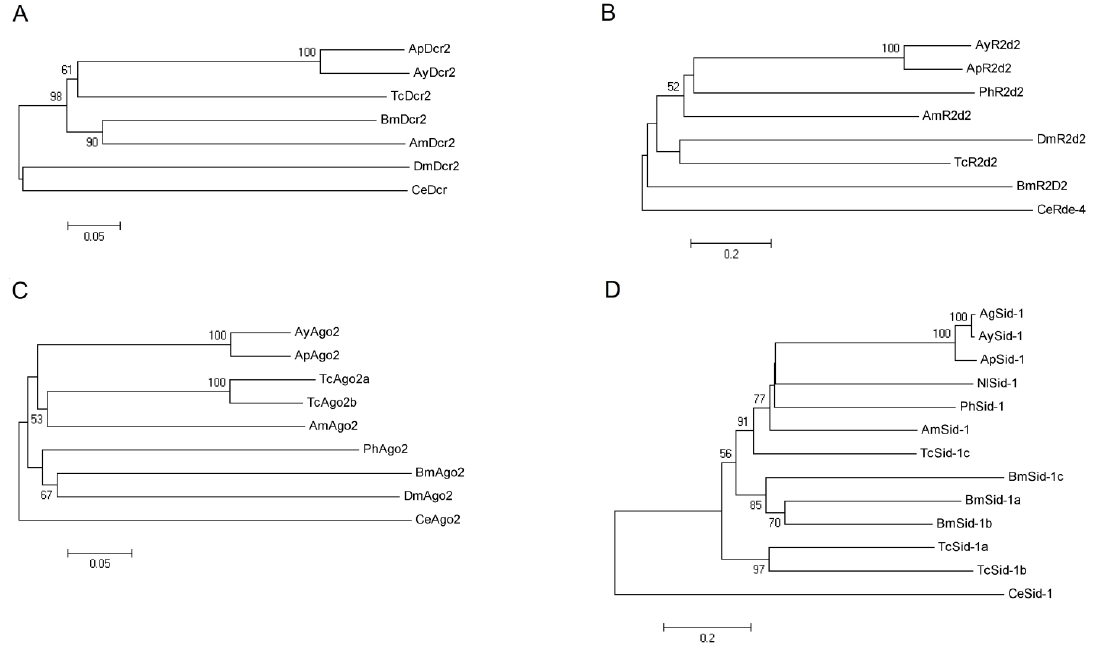
Figure 5. Phylogeny of insect Dcr2, R2d2, Ago2 and Sid1 proteins. The phylogenetic trees were constructed from amino acid sequences corresponding to RNAse IIIa, DS_RBD1, and PIWI domains of insect Dcr2 ( A ), R2d2 ( B ), and Ago2 ( C ) respectively. Full length protein sequences were used to construct the phylogenetic tree for Sid1 ( D ). The percentages of replicate trees in which the sequences clustered together in the bootstrap test (10000 replicates) are shown (only above 50%) next to the branches. The tree is drawn to scale, with branch lengths in the same units as those of the evolutionary distances used to infer the phylogenetic tree. The scale bar represents 0.2 ( B and D ) or 0.05 ( A and C ) expected substitutions per amino acid position. Various proteins for phylogenetic analysis were from Acyrthosiphon pisum (Ap), Aphis glycines (Ay), Aphis gossypii (Ag), Drosophila melanogaster (Dm), Nilaparvata lugens (Nl), Pediculus humanus (Ph), and Tribolium castaneum